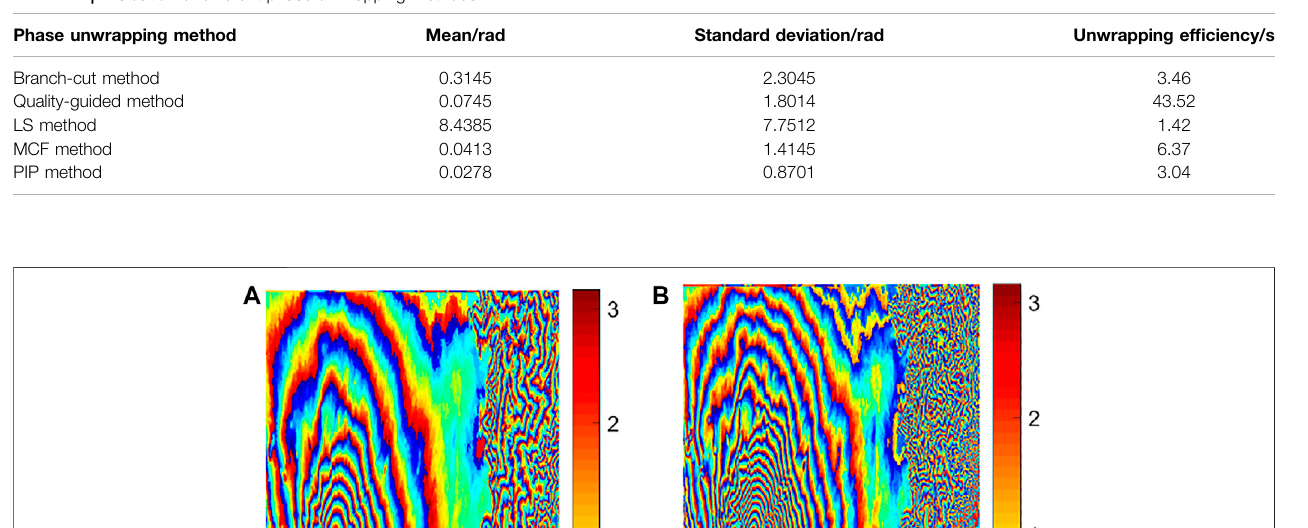
Frontiers in Environmental Science |